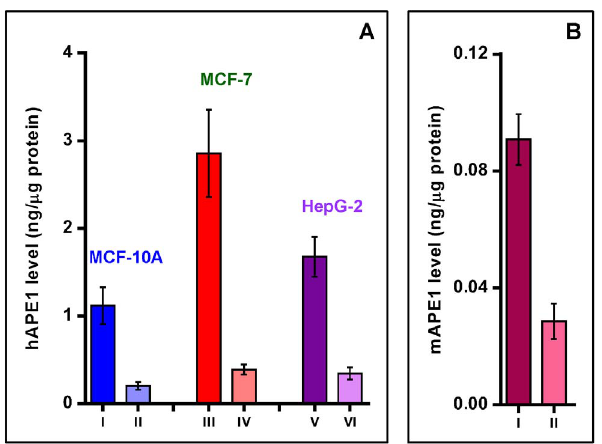
Figure 7. Levels of APE1 (ng/ m g protein) in nuclear extracts (I, III and V) and cytoplasmic extracts (II, IV and VI) of MCF-10A, MCF-7 and HepG2 cells (A), and in nuclear extract (I) and cytoplasmic extract (II) of mouse liver (B). The uncertainties are standard deviations. Statistical analysis: A : I vs. II, p =0.0015; III vs. IV and V vs. VI, p , 0.0001; I vs. III and III vs. V, p , 0.0001; I vs. V, p =0.026; II vs. IV, p , 0.0001; II vs. VI, p =0.035. There is no statistical difference between IV and VI. B : I vs. II, p , 0.0001.